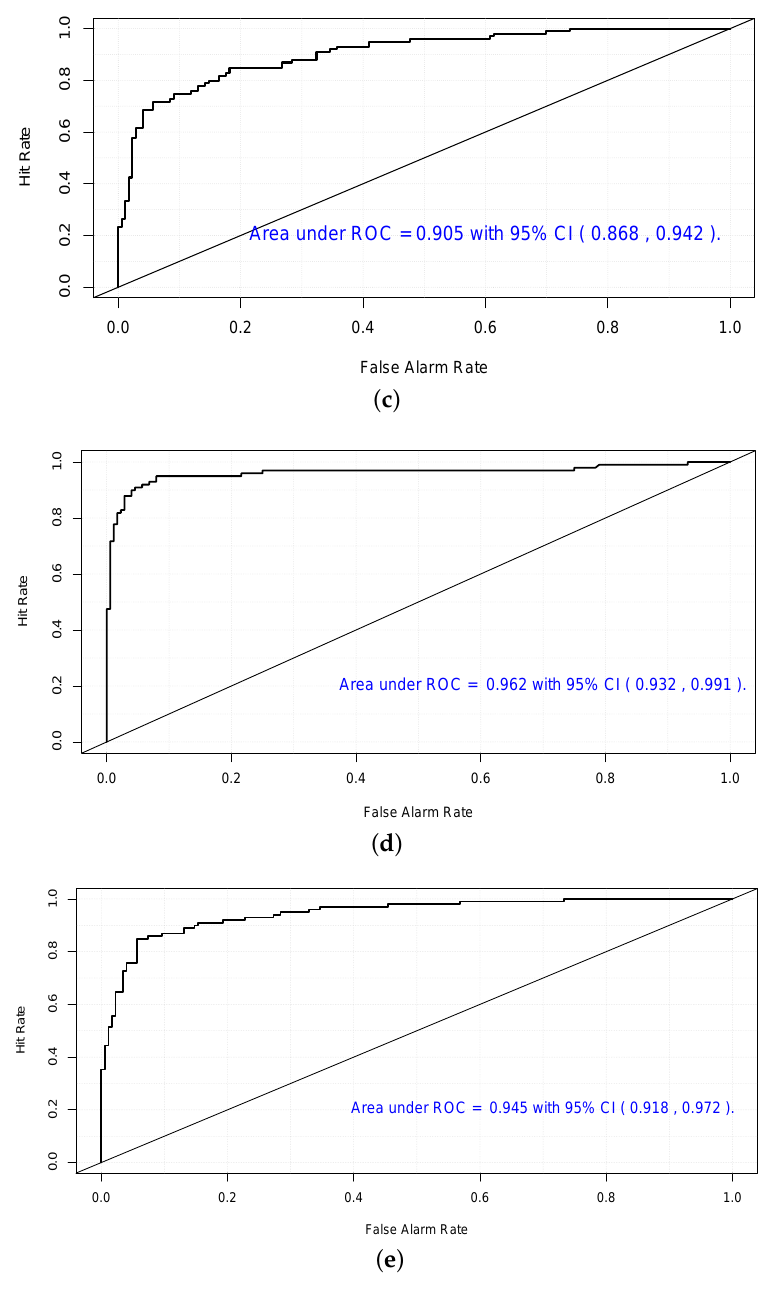
Figure 9. ( a ) ROC curve for logistic regression. ( b ) ROC curve for ridge regression. ( c ) ROC curve for MARS model. ( d ) ROC curve for random forest. ( e ) ROC curve for SVM